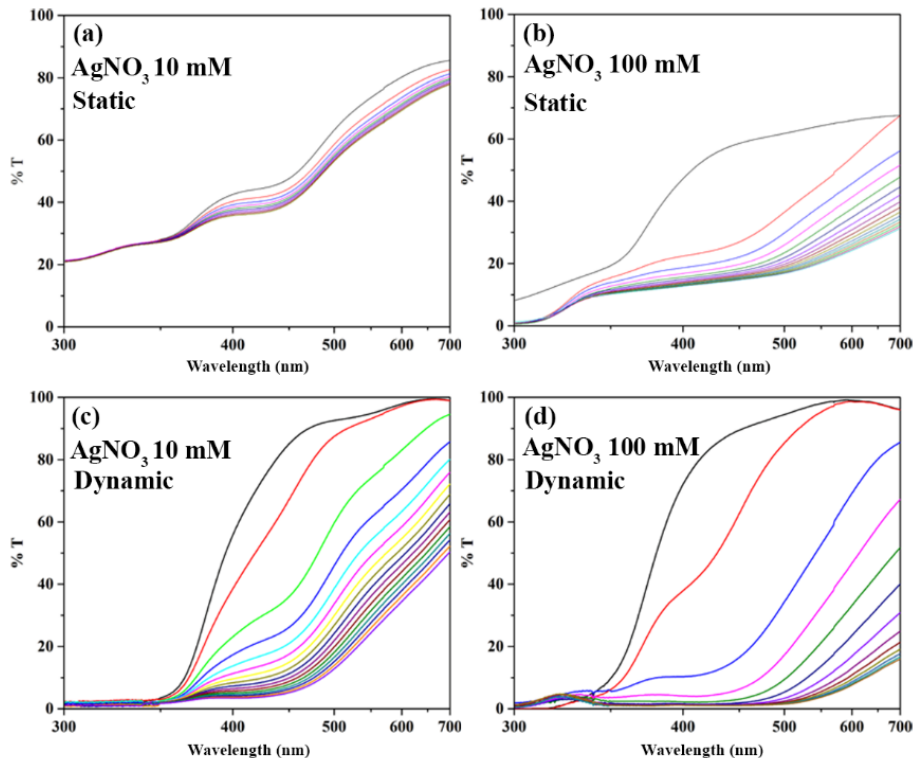
Figure 2. UV–Vis transmittance spectra of the chip showing the plasmonic dip evolution from 0 min. (black curve, water filled chip) to the final reaction time, with a 1 minute step (the same colour sequence is used in all graphs, starting from the red curve, corresponding to the silver precursor injection) for different synthesis conditions: ( a ) static synthesis using a 10 mM AgNO 3 solution at 20 °C; ( b ) static synthesis using a 100 mM AgNO 3 solution at 20 °C; ( c ) dynamic synthesis using a 10 mM AgNO 3 solution at 20 °C with a flow rate of 1 mL/min; ( d ) dynamic synthesis using a 100 mM AgNO 3 solution at 20 °C with a flow rate of 1 mL/min